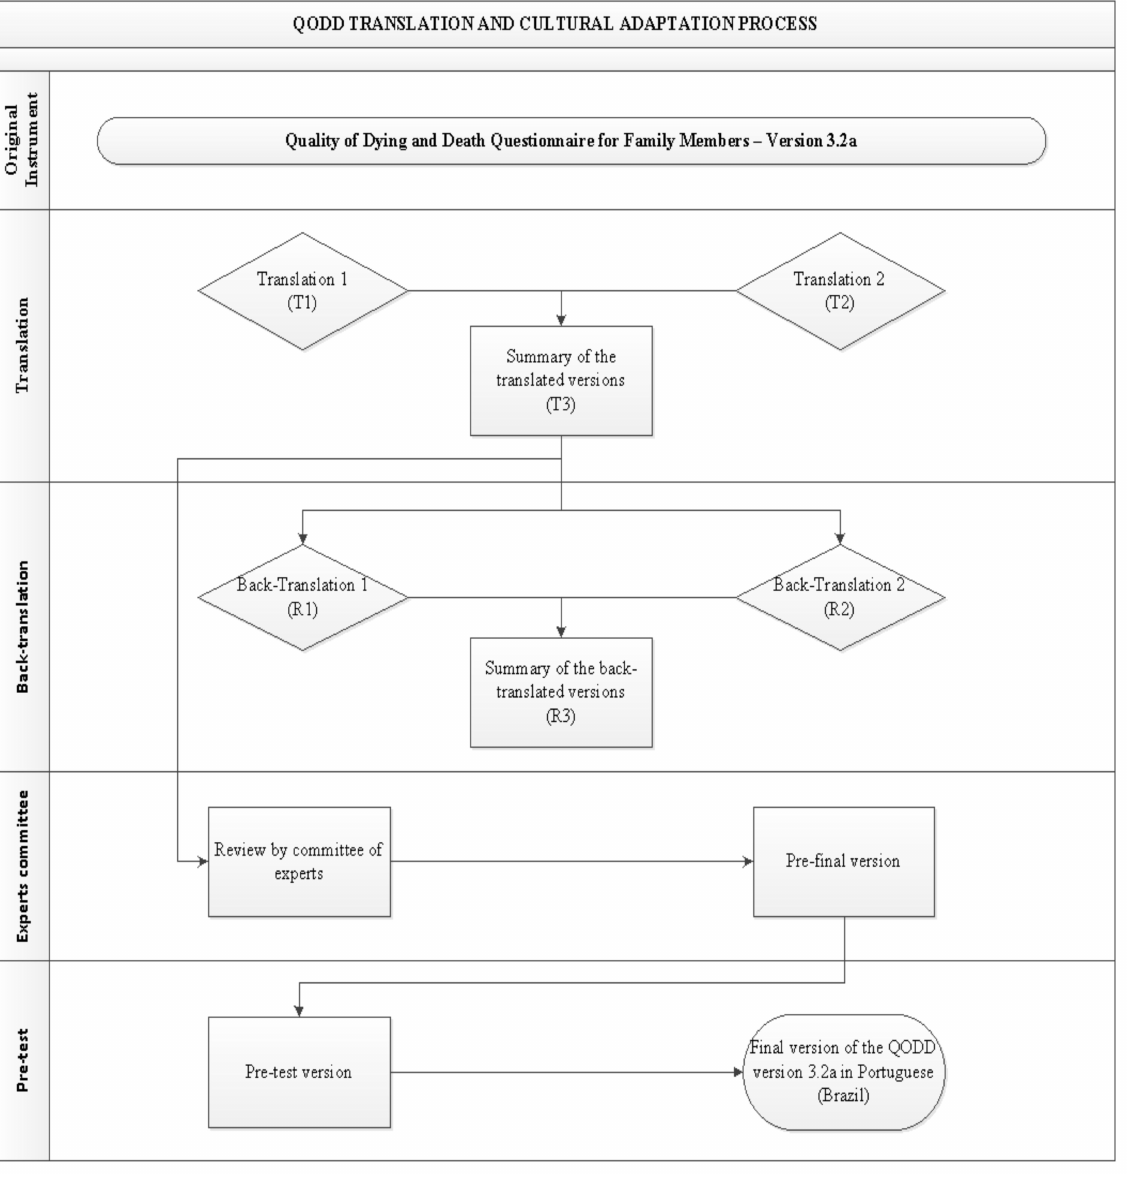
Figure 1. Flowchart of the QODD translation and cultural adaptation process into Portuguese, Botucatu, SP, Brazil,